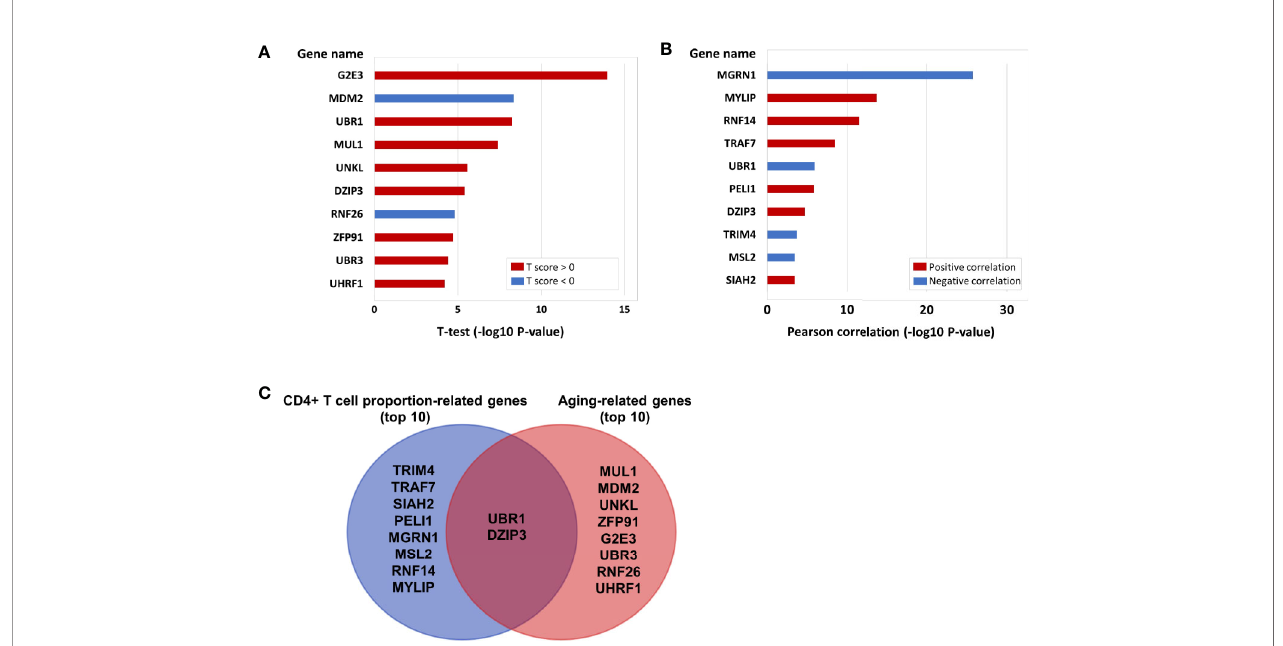
FIGURE 2 | (A) The E3 gene list that is signi fi cantly associated with aging (top 10). (B) The E3 gene list that is signi fi cantly associated with CD4+ T cell proportion (top 10). (C) The intersecting genes that are signi fi cantly associated with both aging (top 10) and CD4+ T cell proportion (top 10).